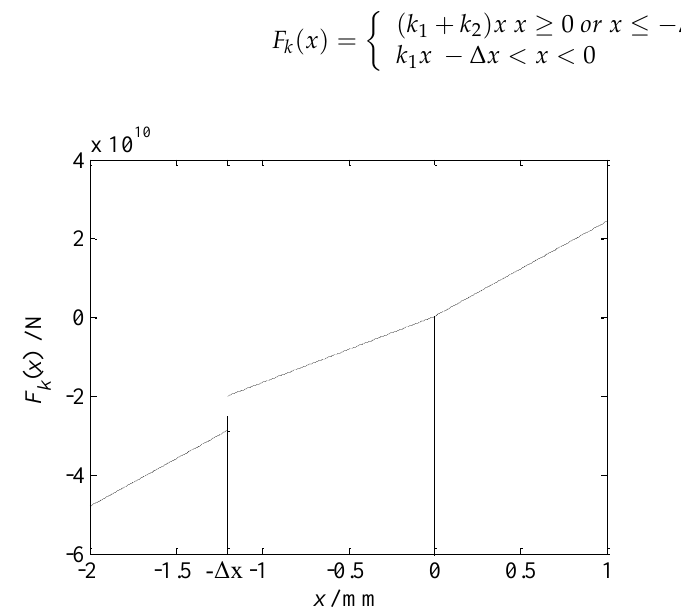
Figure 7. Piecewise stiffness force function of hot rolling mill rolls in the horizontal direction.